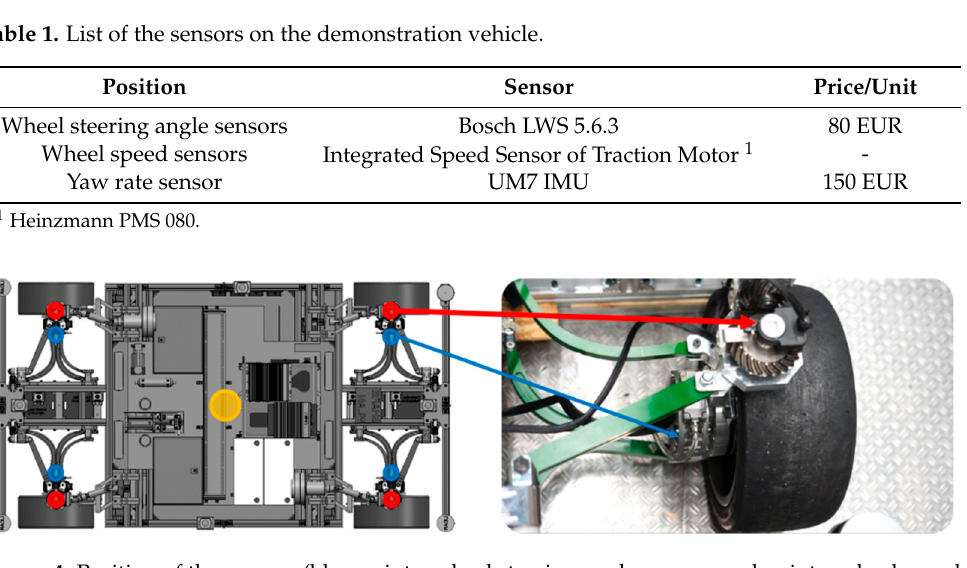
Figure 3. Functional sequence of a state estimator.